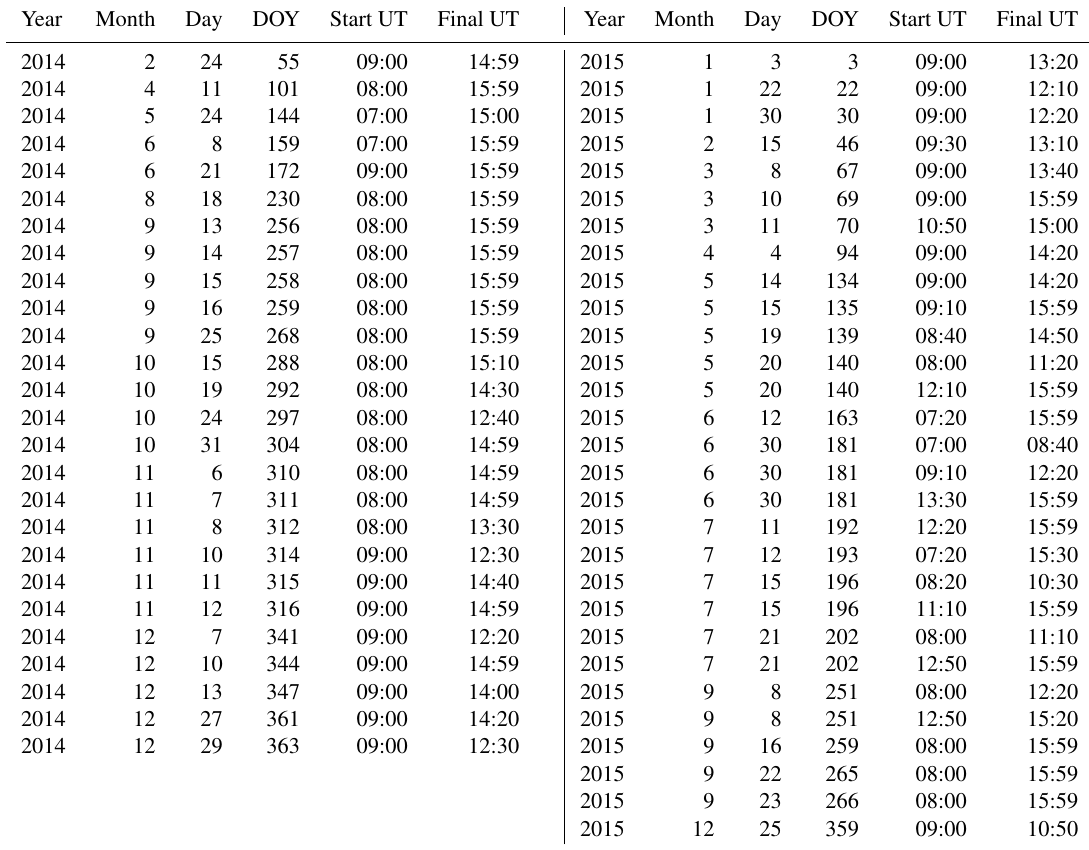
Table 2. Intervals with fo F2 obtained from Eq. (1) checked visually. Years 2014–2015, with DOY representing day of the